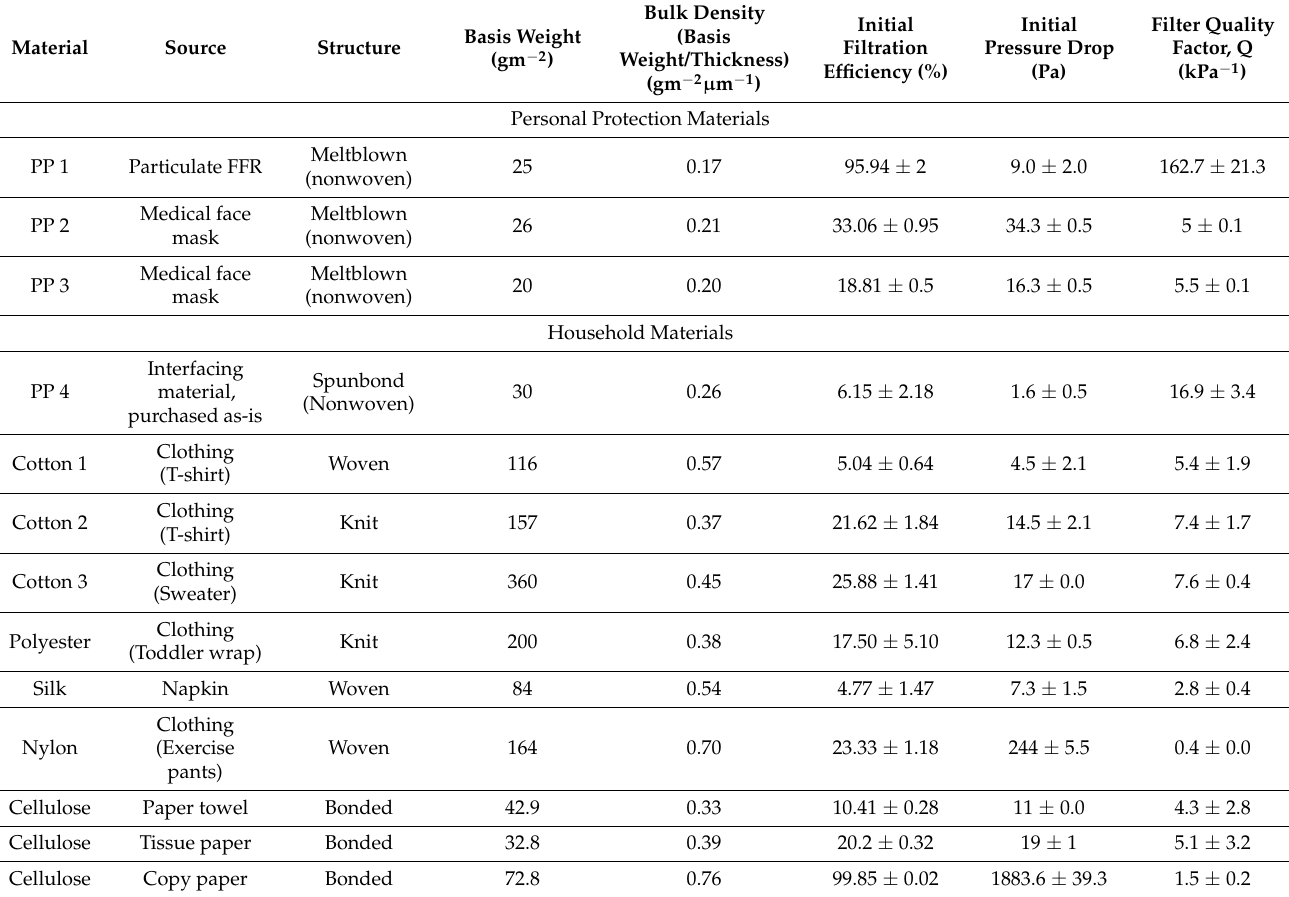
Table 4. Filtration efficacy of different mask fabrics